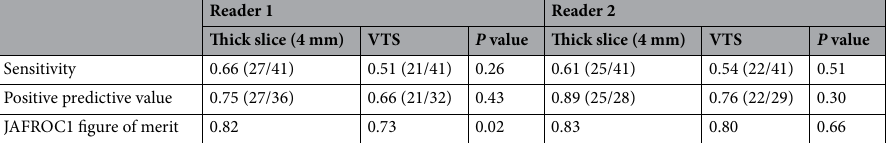
Table 4. Diagnostic performance for detecting compression fractures. Numbers in parentheses are actual numbers of lesions. VTS virtual thin slice, JAFROC Jackknife alternative free-response receiver-operating characteristic.